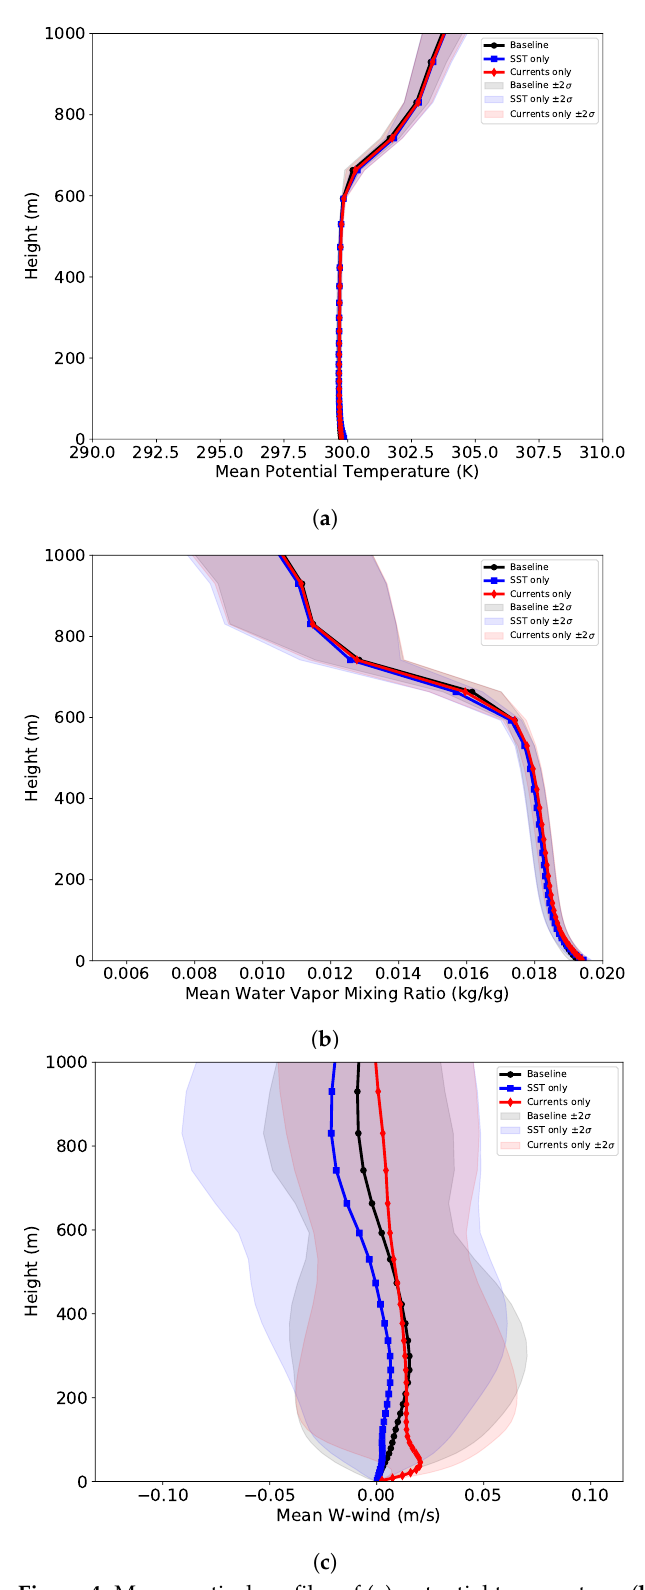
Figure 4. Mean vertical profiles of ( a ) potential temperature, ( b ) water vapor mixing ratio, and ( c ) vertical wind velocity. Shaded regions represent ± 2 σ from the mean value. The computational domain of the ocean model has the dimensions of − 500 m < y < 500 m by − 500 m < z < 0 m and a nominal cell size of 0.3 m. The time step size is